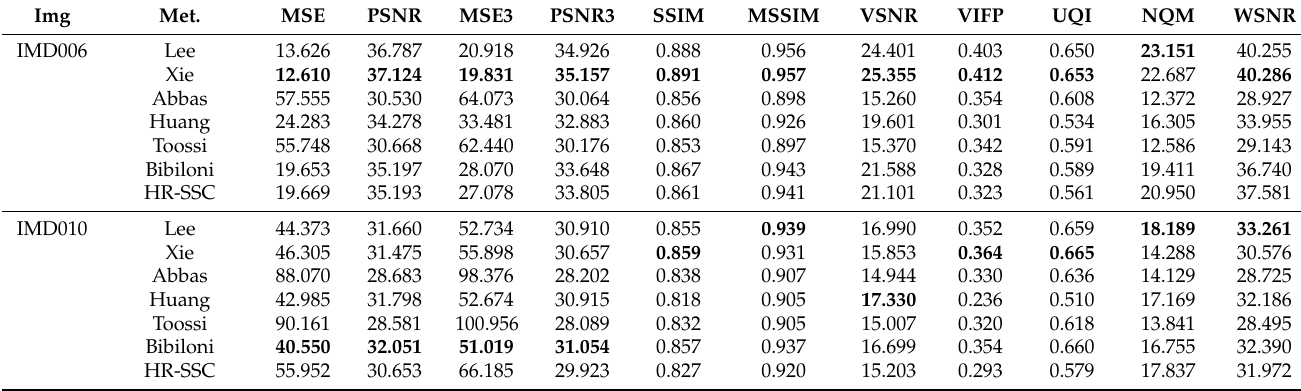
Figure 16. Trends of quality measures on H13Sim-data for the methods Lee, Xie, and HR-SSC.